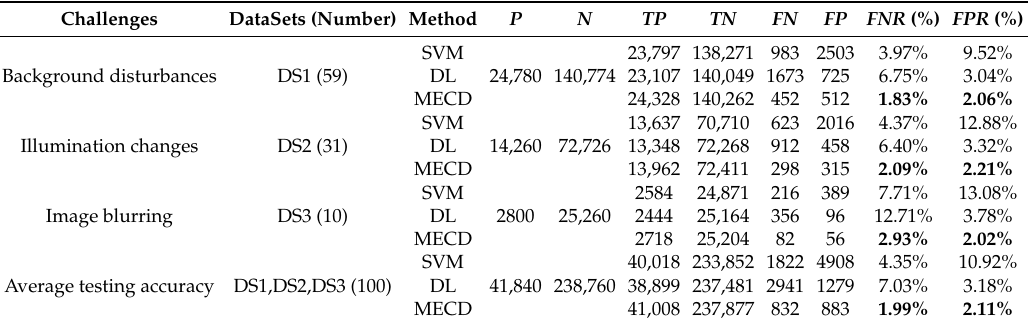
Table 1. Comparisons of crack region testing accuracy. SVM; Support Vector